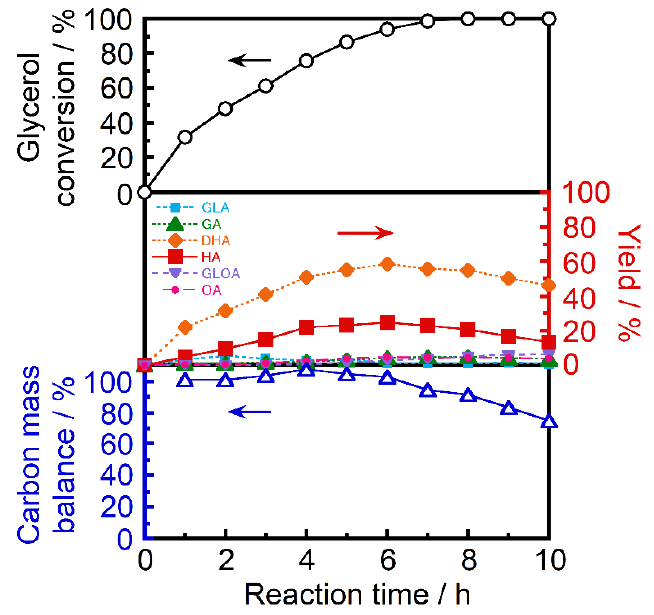
Figure 4. Glycerol conversion, the product yield, and carbon mass balance as functions of reaction times over Pt/CZBi(0.20)Pb(0.05)/SBA at 30 °C in atmospheric air.